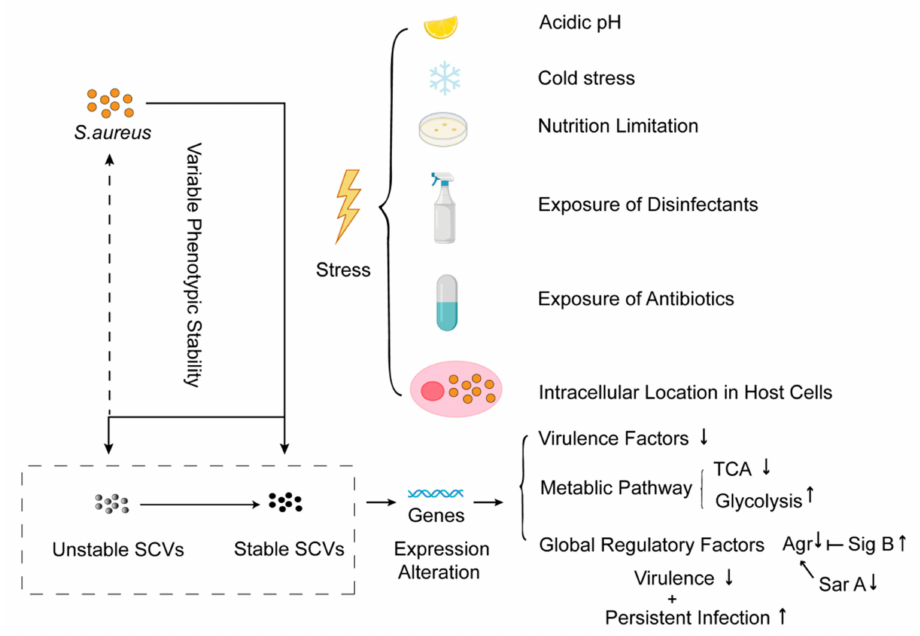
Figure 4. Formation and characteristics of S. aureus